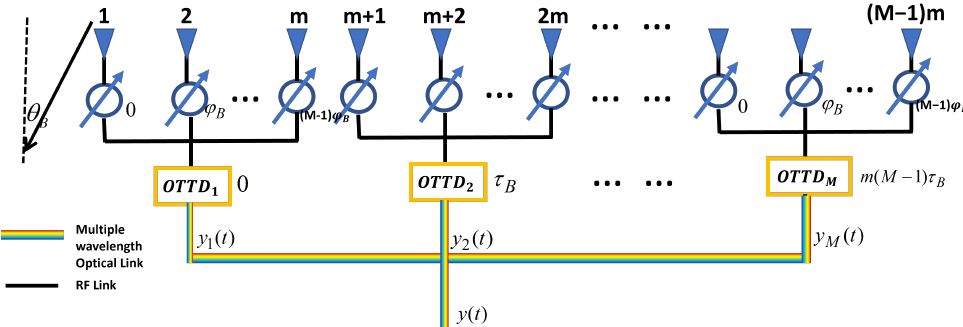
Figure 4. Principle of AWGR Assisted Mm-wave Beam-hopping